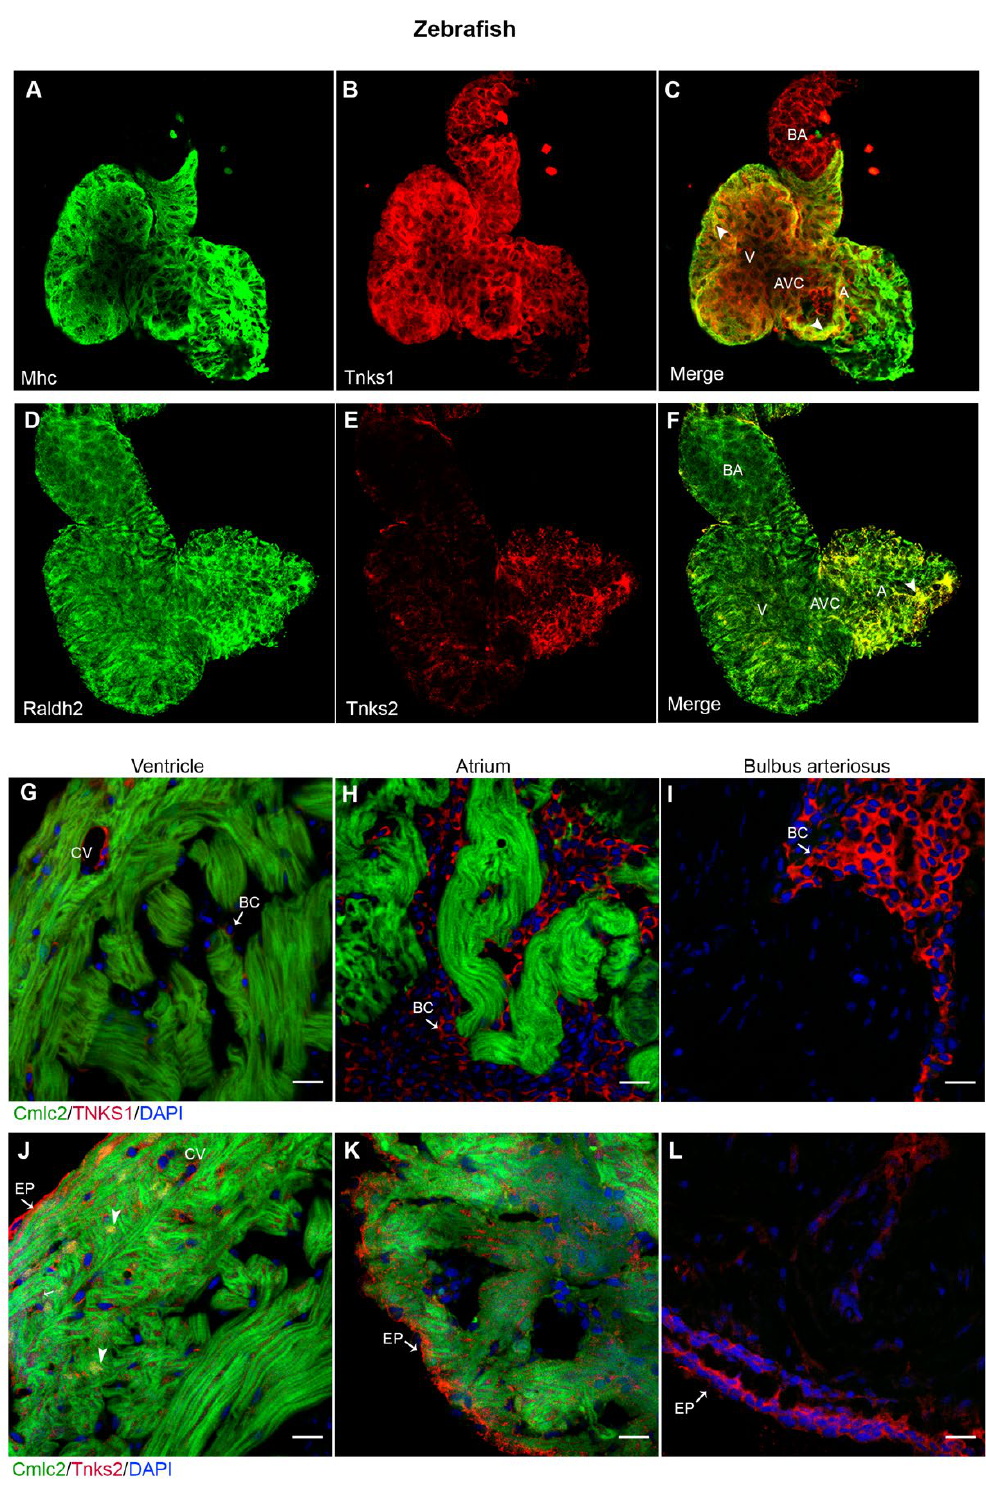
Figure 6. Tnks1 and Tnks2 display a distinct expression pattern in zebrafish developing and adult hearts. ( A – C ) Confocal images of whole-mount immunostaining for Mhc ( A ) and Tnks1 ( B ) in dissected zebrafish heart at 4 dpf. Tnks1 is co-expressed with Mhc in the ventricle (arrowhead) and atrium (arrowhead): A, atrium; V, ventricle; BA, bulbus arteriosus; AVC, atrioventricular canal. ( D – F ) Representative confocal images of whole-mount immunostaining for Raldh2 ( D ) and Tnks2 ( E ) in dissected zebrafish heart at 4 dpf. Tnks2 is co-expressed with Radldh2 in the epicardium (arrow- head). ( G – I ) Representative immunostaining of adult heart sections from transgenic zebrafish Tg ( cmlc2 : GFP ) for Tnks1 (in red) in ventricle ( G ), atrium ( H ), and bulbus arteriosus ( I ). The Tnks1-